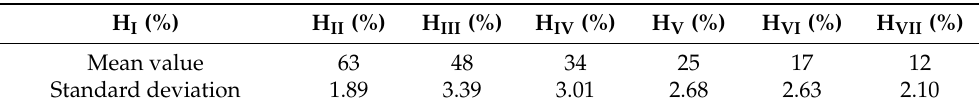
Table 4. The results of ultrasonic measurements used to determine the attenuation in samples produced using standard technology (the complete set of results are available in the Appendix A in Table A2).